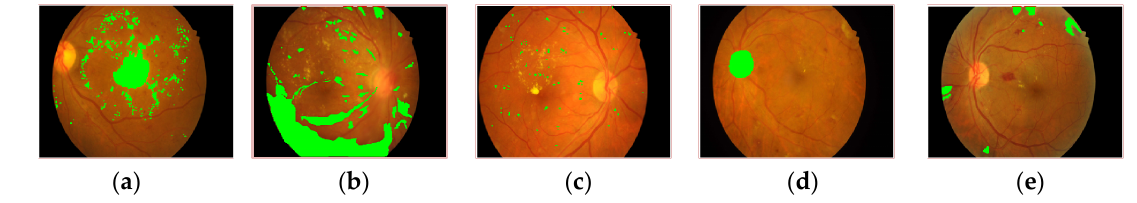
Figure 1. Symptoms of NPDR lesions [9]: ( a ) HEs ( b ) HMs ( c ) MAs ( d ) OD ( e ) SoEX. Manual DR detection is an error-prone and significant task for an ophthalmologist.